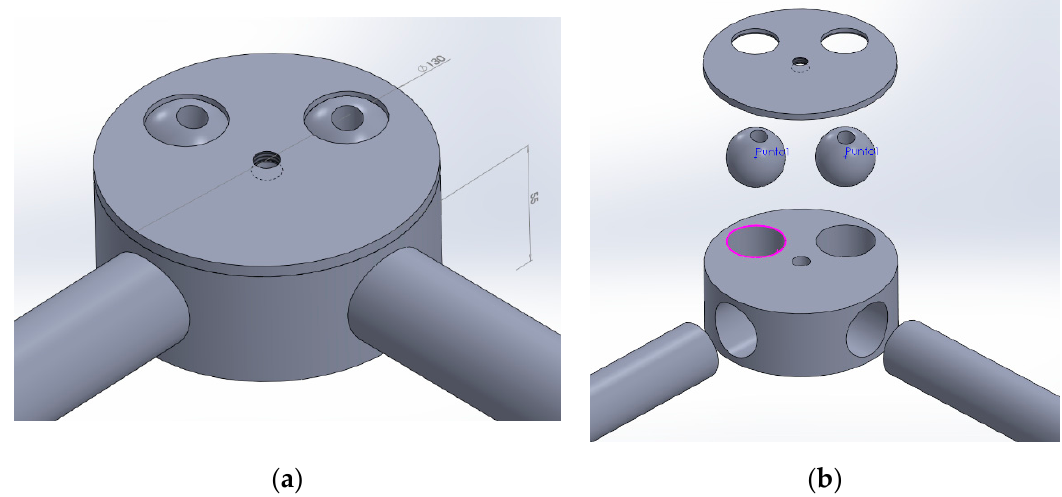
Figure 7. Structural node version 1: assembly view ( a ); exploded view ( b ).